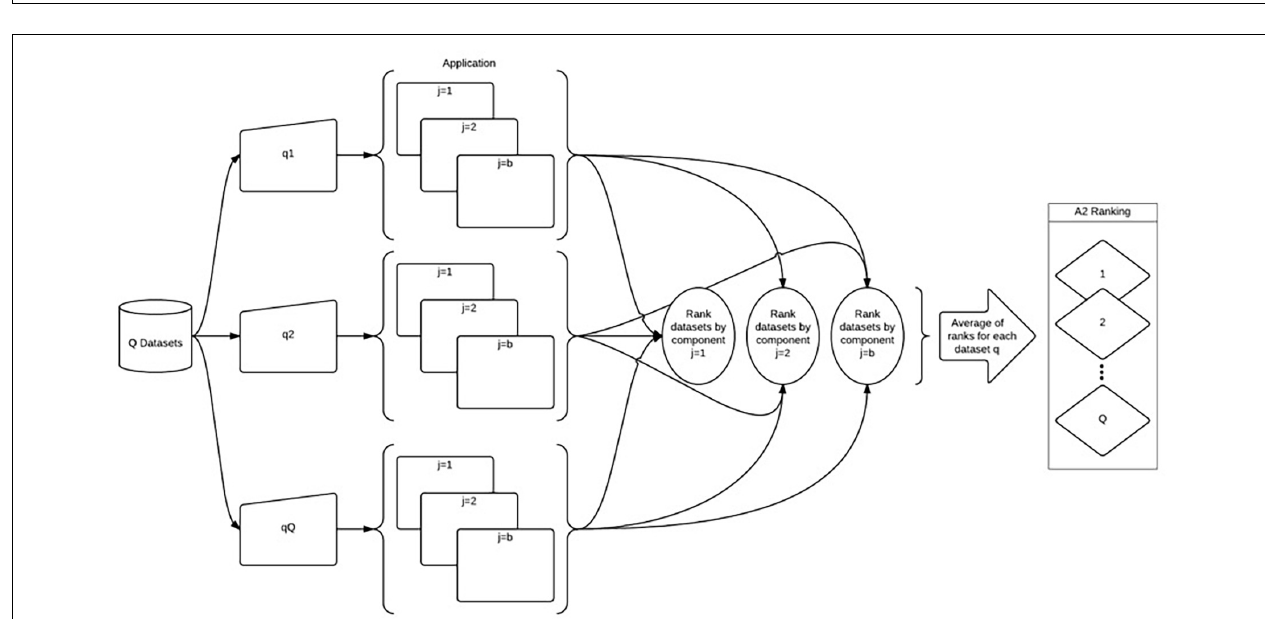
FIGURE 4 | Application (A2) component, adapted from Shimizu